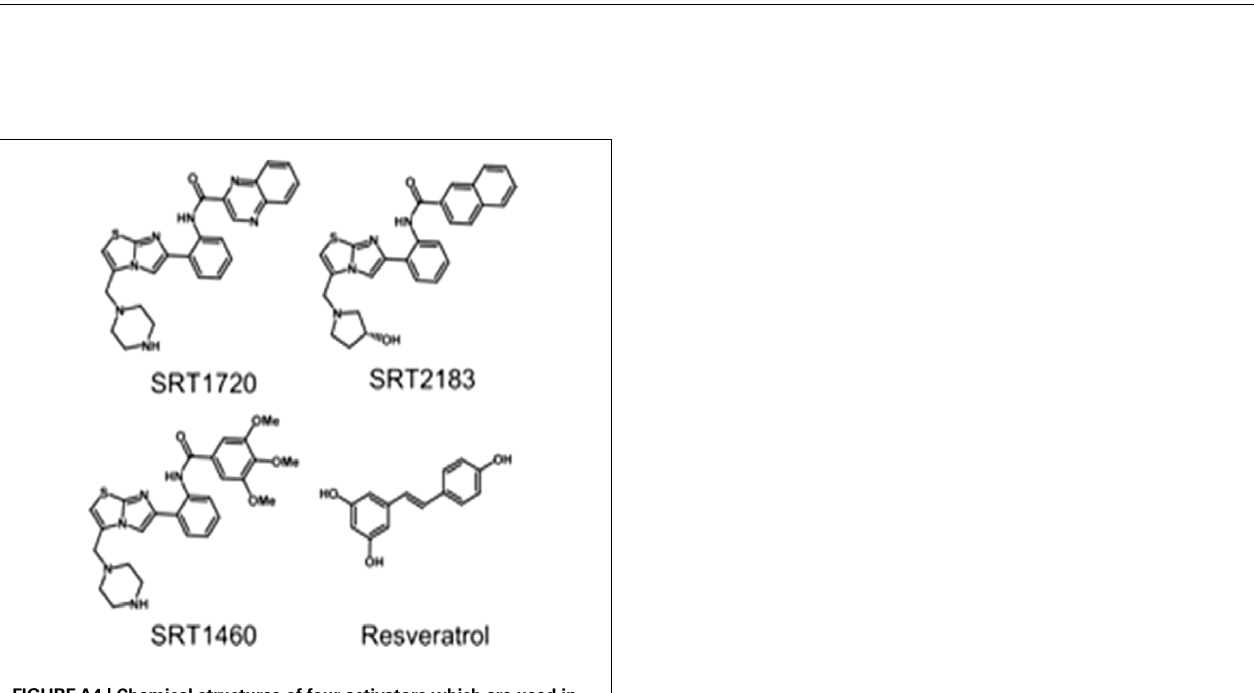
FIGUREA4 | Chemical structures of four activators which are used in molecular docking studies against Sirt-1 (Pacholec et al., 2010).